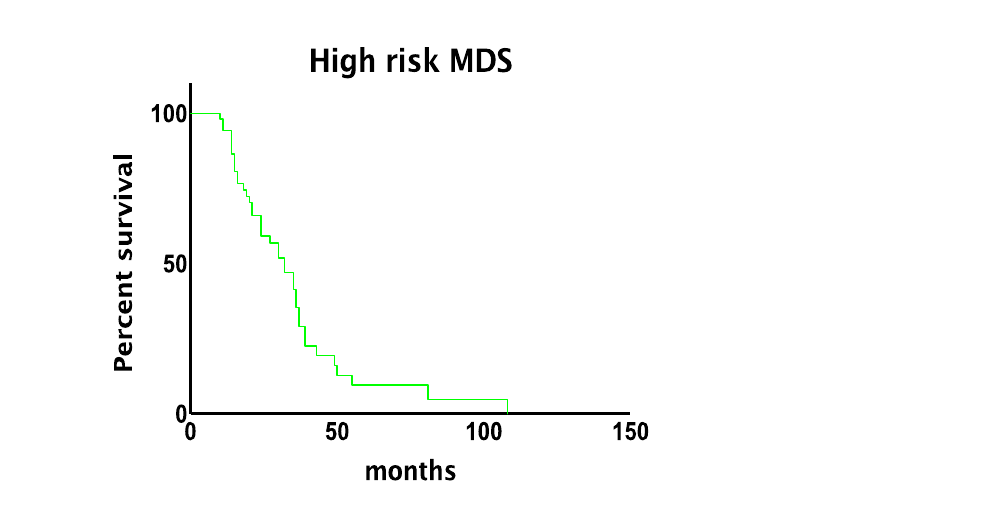
Figure 1. Median overall survival of high-risk myelodysplastic syndromes.